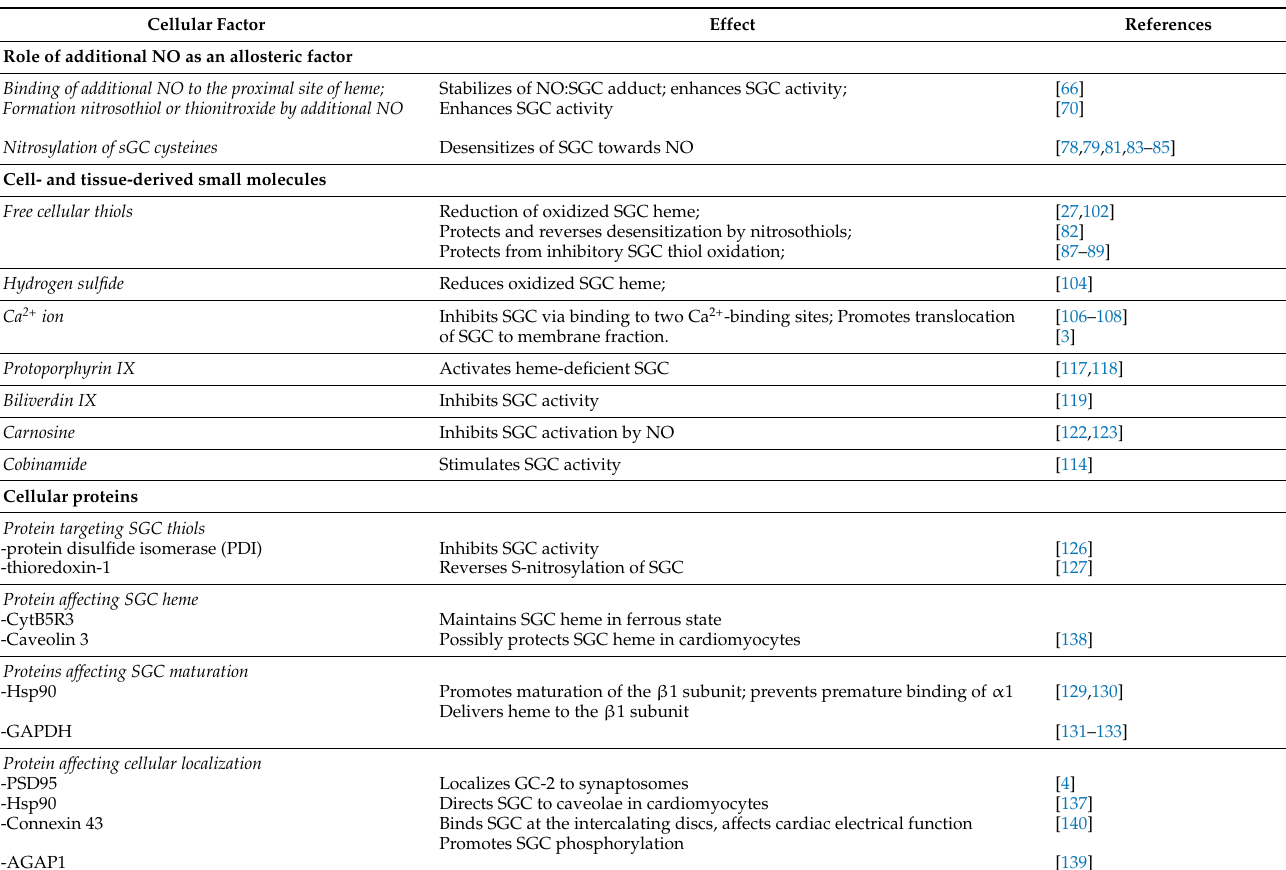
Table 1. Cellular factors modulating the activity and function of